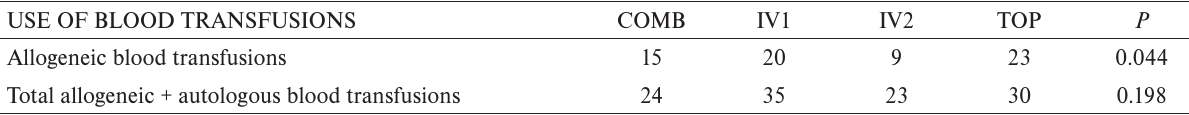
Table 5. Comparison of the use of allogeneic blood transfusions.